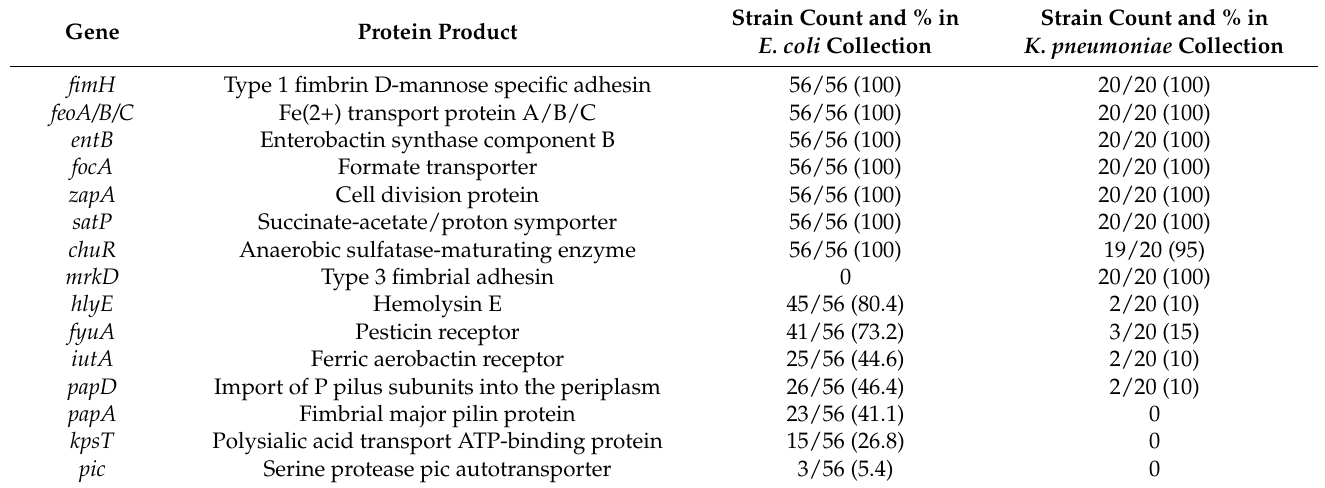
Table 1. UTI virulence marker genes present in the pangenome of N = 55 E. coli and N = 19 K. pneumoniae isolates (including the reference genomes for each species collection). Proportion of the samples containing the gene are shown in count of strains with gene over the total strains and %